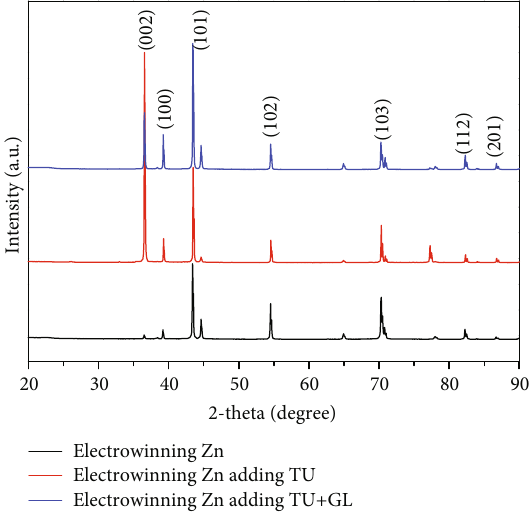
Figure 3: XRD patterns of zinc foil by